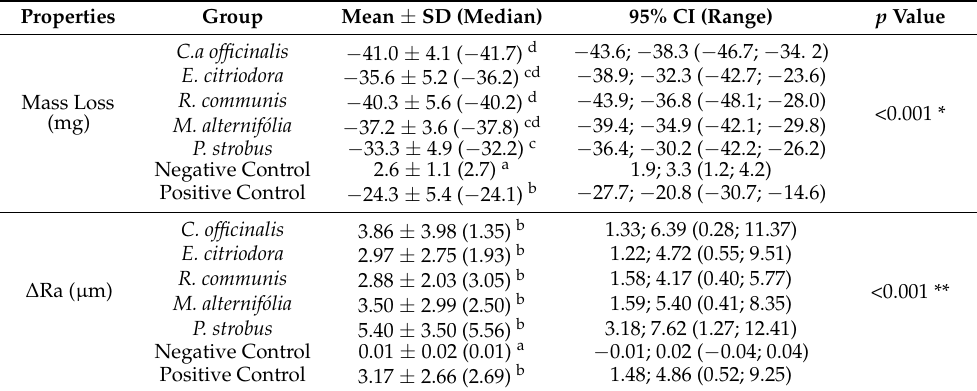
Table 2. Descriptive statistics of mass loss (mg), variation in roughness ( ∆ Ra– µ m) and statistical comparisons.